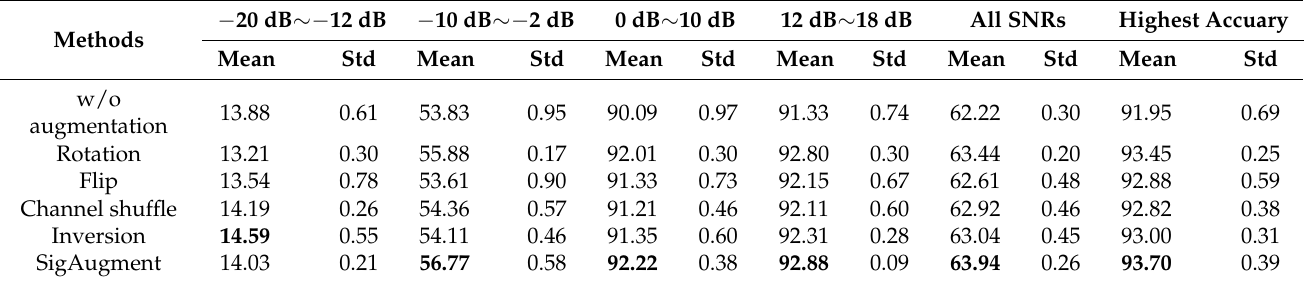
Table 7. Accuracy of LENet-S with varying augmentation methods. The top1 accuracy for each SNR interval is highlighted. w/o denotes